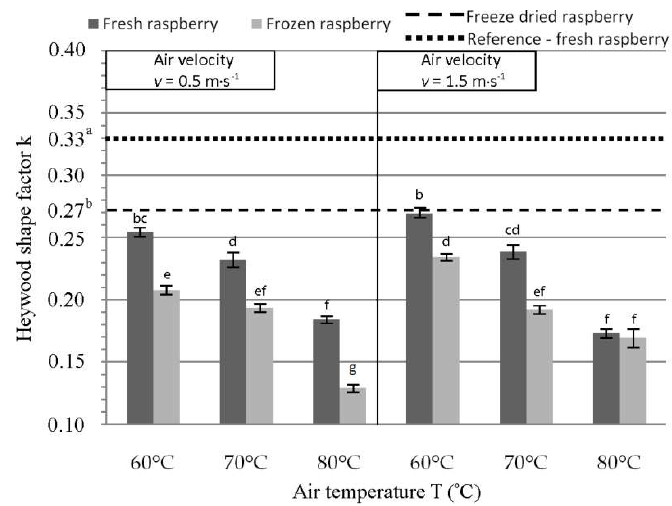
Figure 3. Of Heywood shape factor after convective drying of Polana raspberry. Di ff erent lowercase Figure 3. of Heywood shape factor after convective drying of Polana raspberry. Different lowercase letters indicate significant di ff erences ( p < letters indicate significant differences ( p < 0.05).